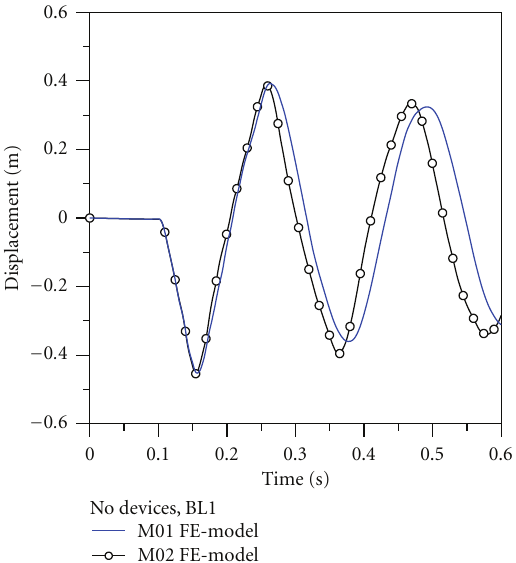
Figure 12: Comparison of midspan cable deflection, as a function of time (ABAQUS). No devices. M01 and M02 FE-models, BL1.